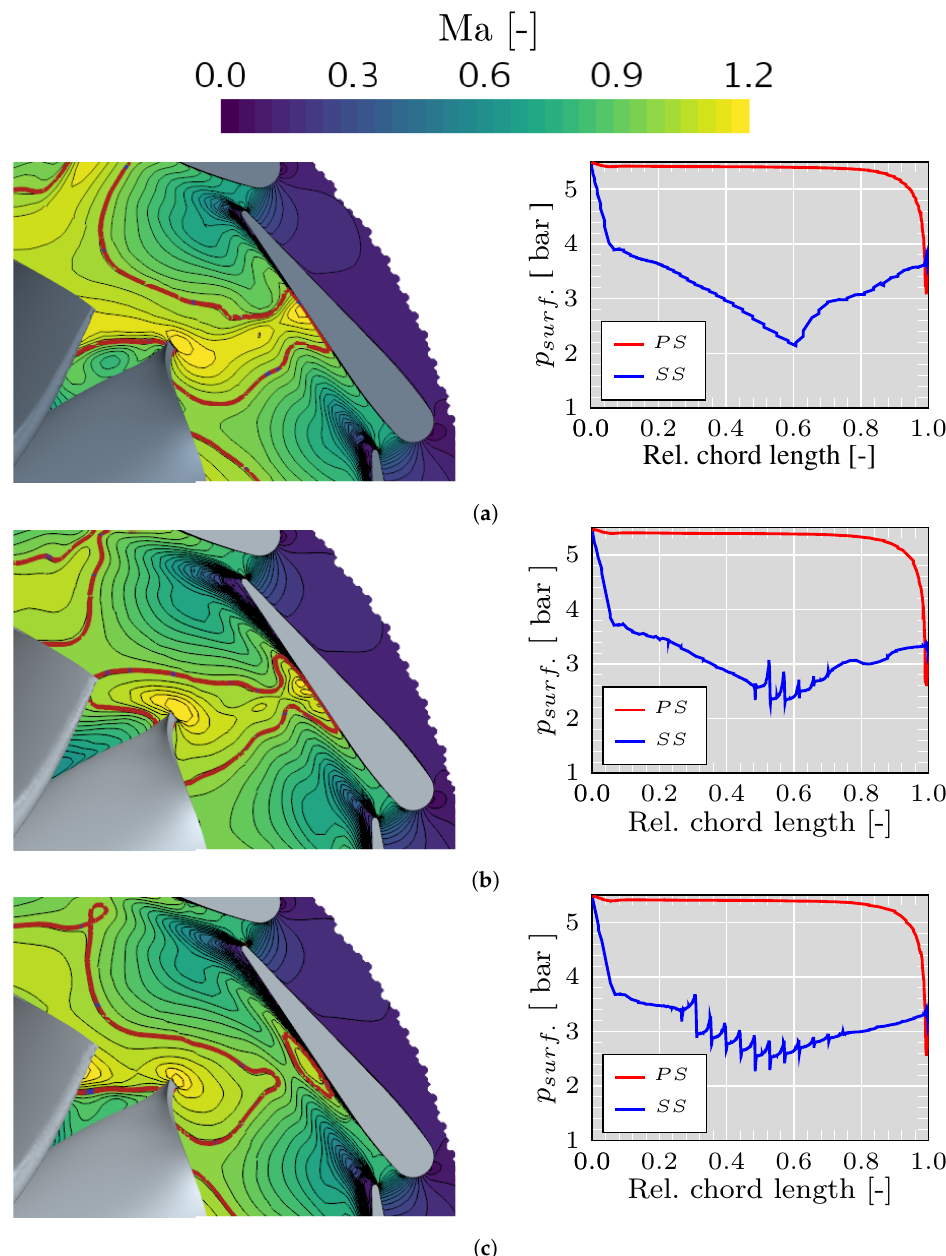
Figure 9. Mach number and stator vane pressure profile snapshots of URANS simulations at 50% span of the stator passage with closed VGT position at higher speed and higher PR; red line: Ma = 1. ( a ) Geometry with 0 grooves (original configuration). ( b ) Geometry with 5 grooves on the stator vanes. ( c ) Geometry with 11 grooves on the stator